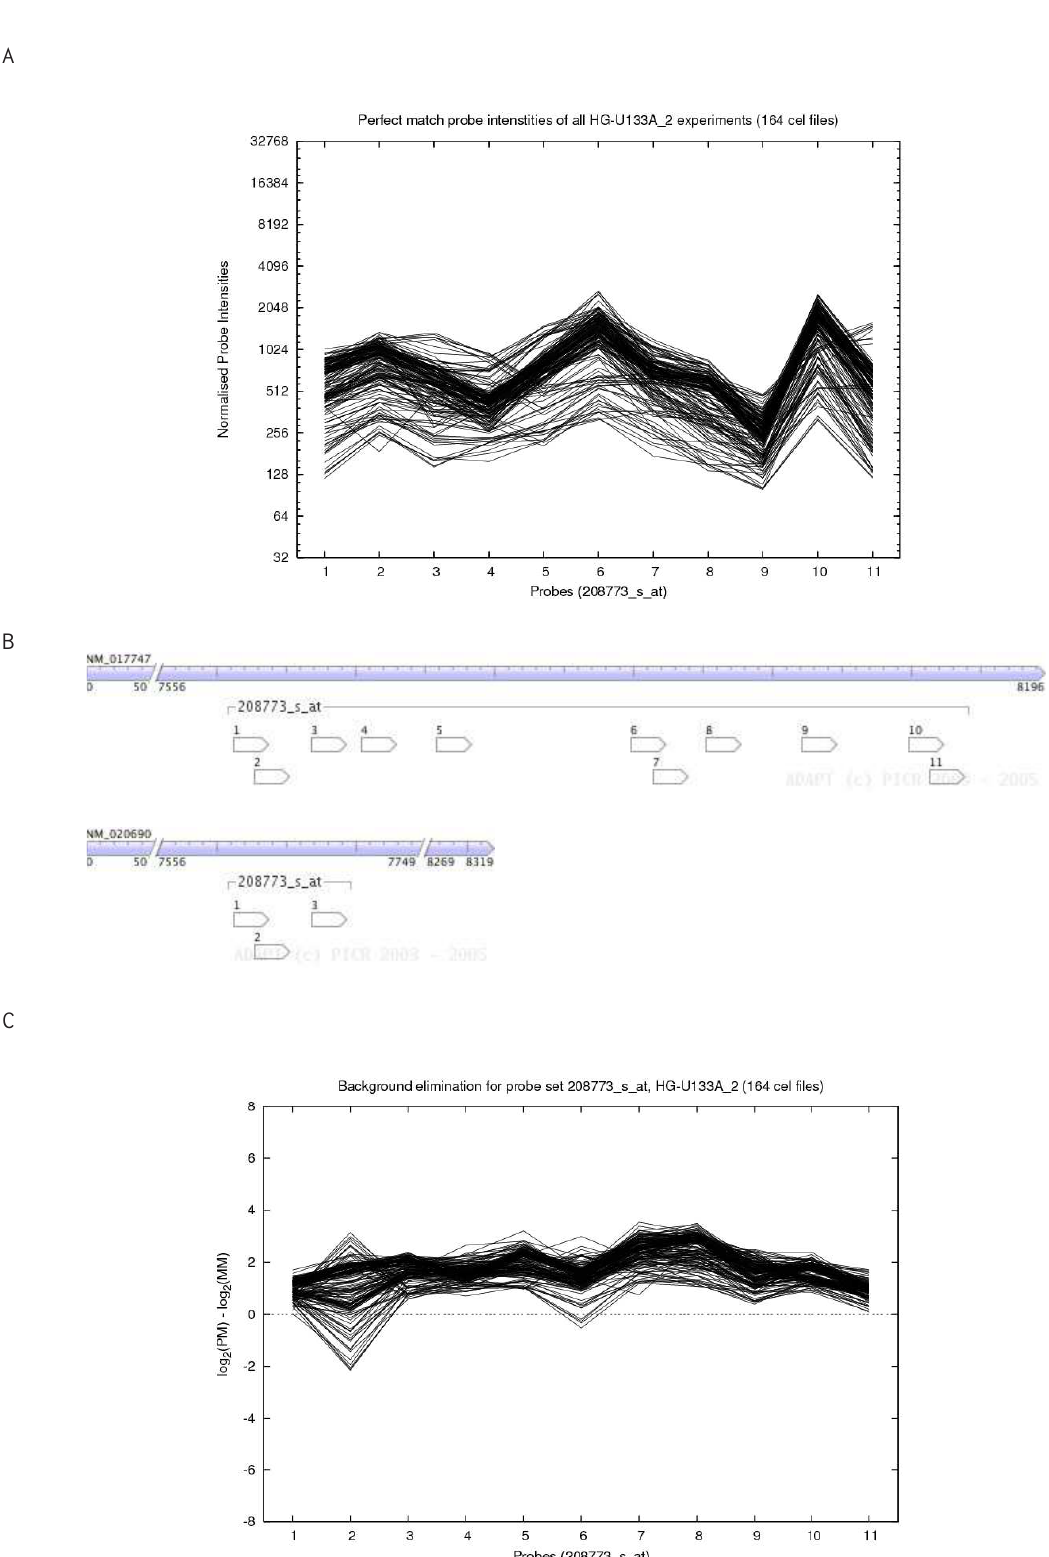
Supplementary Figure 10: Probe intensities over all cel files for probe set 208773 s at on the HG U133A 2 array (A) Perfect match intensities (log scale) (B) ADAPT probe positions on the transcripts (C) Background elimination (log 2 (PM) - log 2